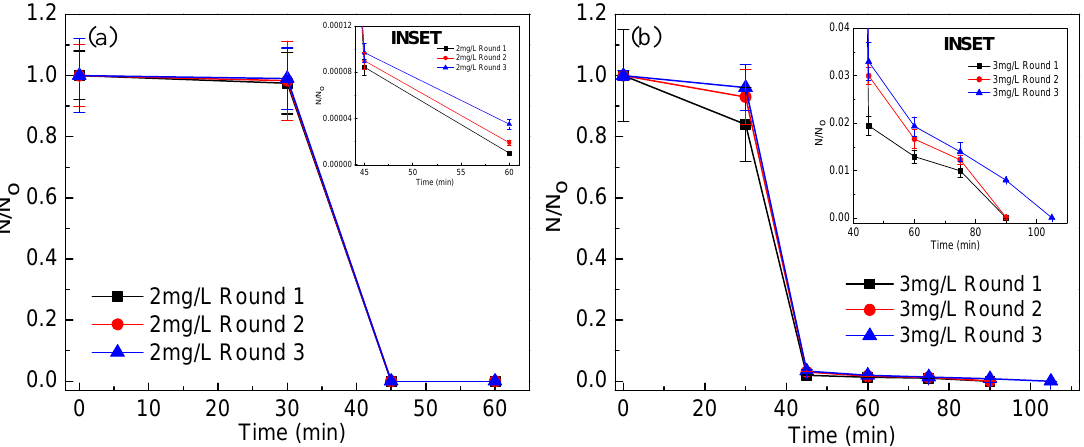
Figure 8. Effect of Ag@ZnO core ‐ shell NPs reusability till three rounds of solar ‐ PCD kinetics of ( a ) E. coli and ( b ) S. aureus . Initial bacteria concentration = 5 × 10 6 CFU/mL, Temperature = 35 ± 2 °C. Error bars indicate the standard deviation of replicates ( n = 3).